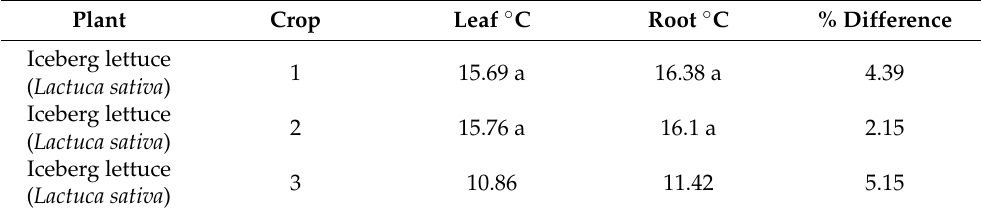
Table 3. Leaf and root average temperature for the three crops. “a” means that there is no significant Table 4. Average fresh mass of lettuce leaves from 3 crops. “a” means that there is no significant difference between leaf and root temperatures for crops 1 and difference between fresh mass for crops 2 and 3.